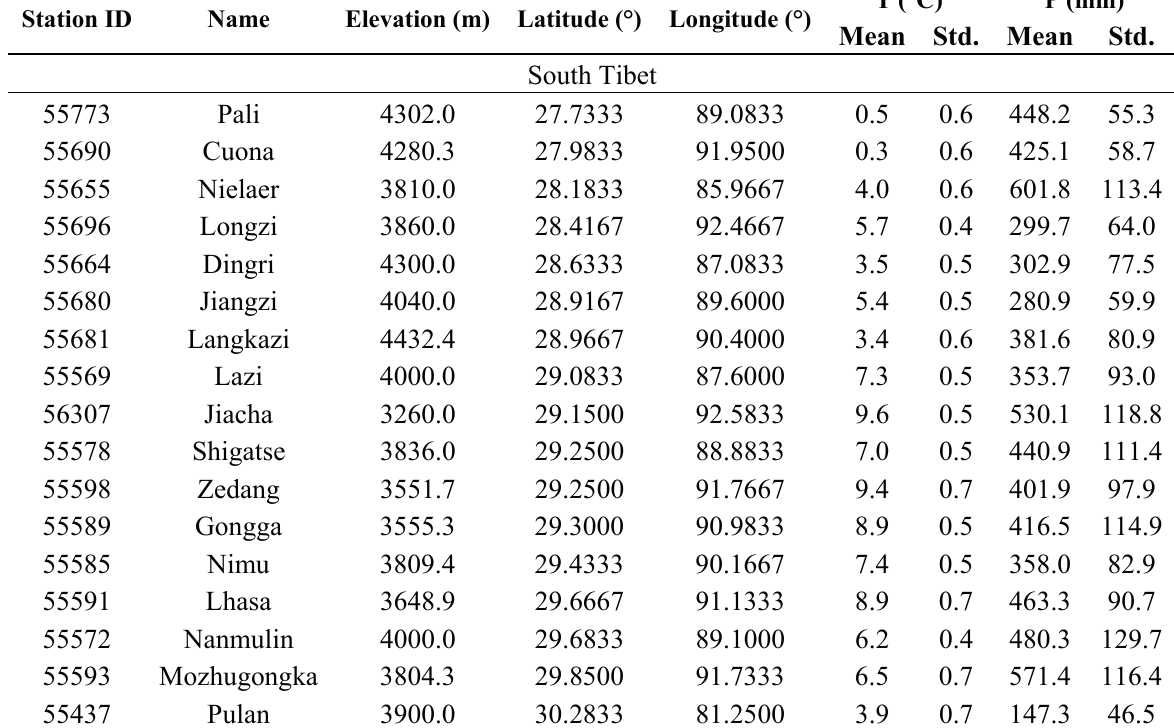
Table 1. Description of selected meteorological stations and two climatic variables temperature (T) and precipitation (P) in different sub-zones of the Tibetan